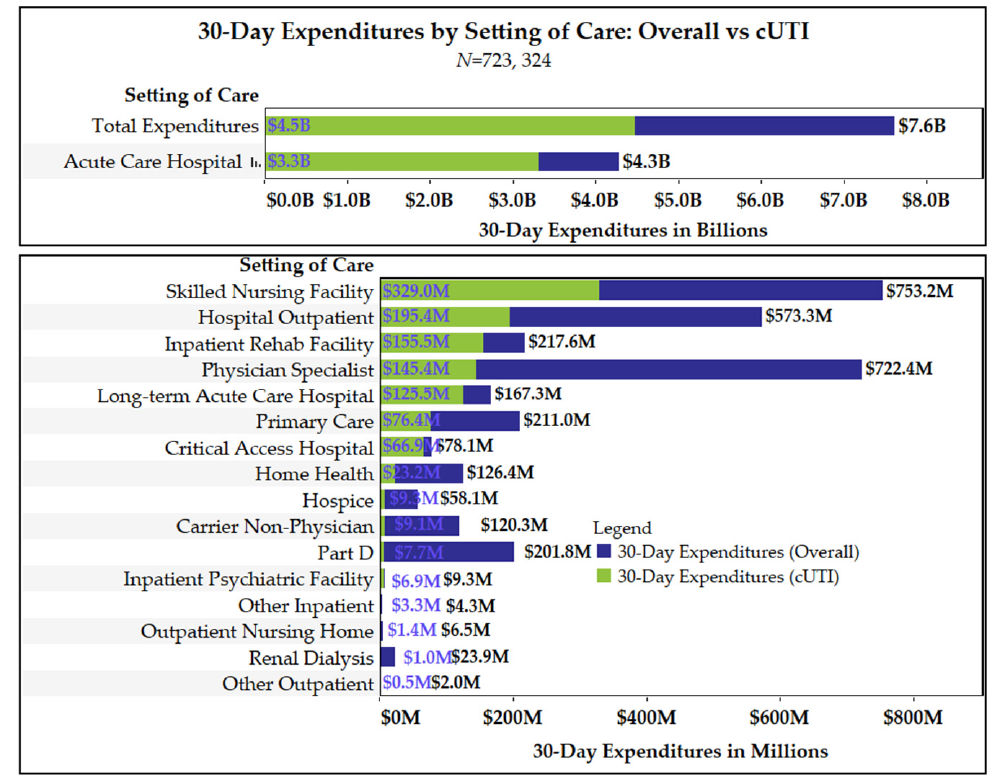
Figure 1. Overall and cUTI-related 30-day Medicare spending by setting of care.